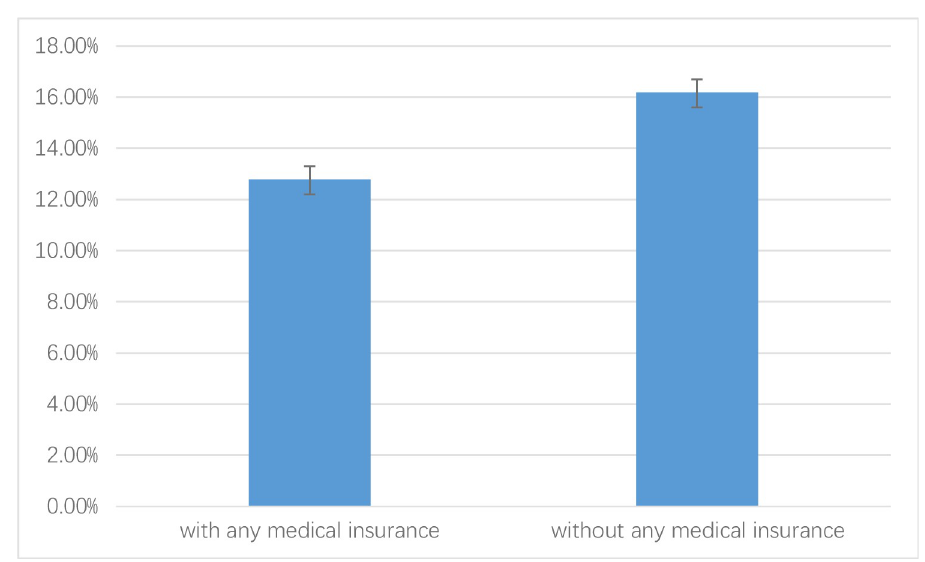
Fig 3. Health insurance and the rate of catastrophic health